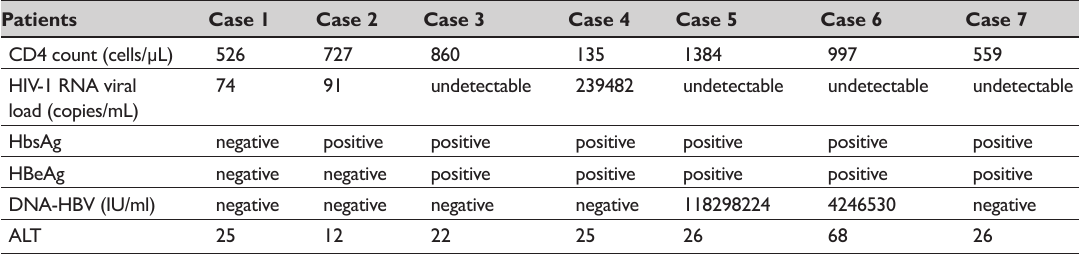
Table 2: Laboratory tests at last follow up clinical visit